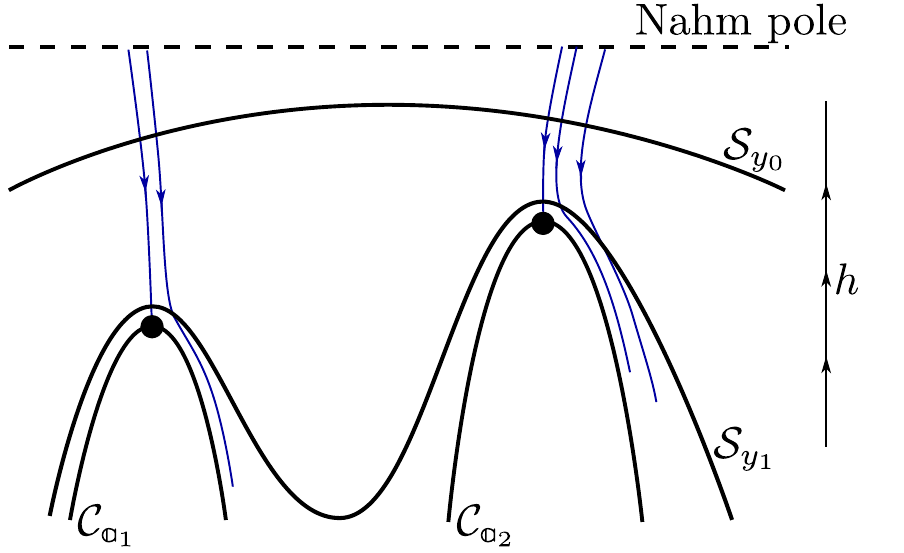
Figure 3 . The functional h grows in the upward vertical direction. The integration cycles S y and S y , y 0 < y 1 , are obtained by (cid:13)owing downward from the Nahm pole. If y 1 is large, the (cid:13)ows 1 (shown in blue) that end up at (cid:12)nite points on S y points a 1 , a 2 . This de(cid:12)nes the decomposition of S y